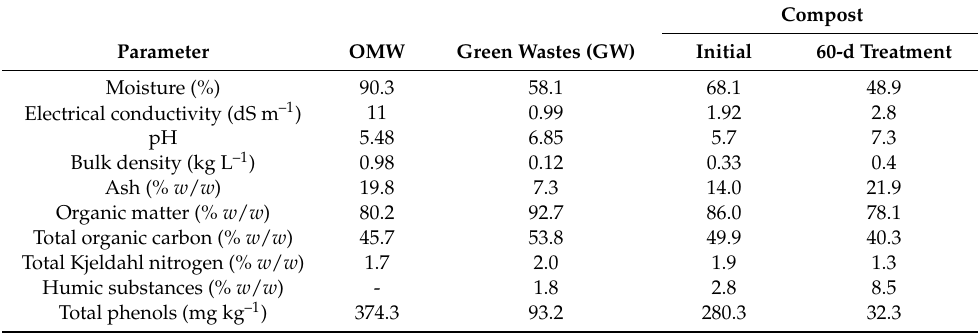
Table 2. Basic physicochemical parameters of olive oil mill waste before and after